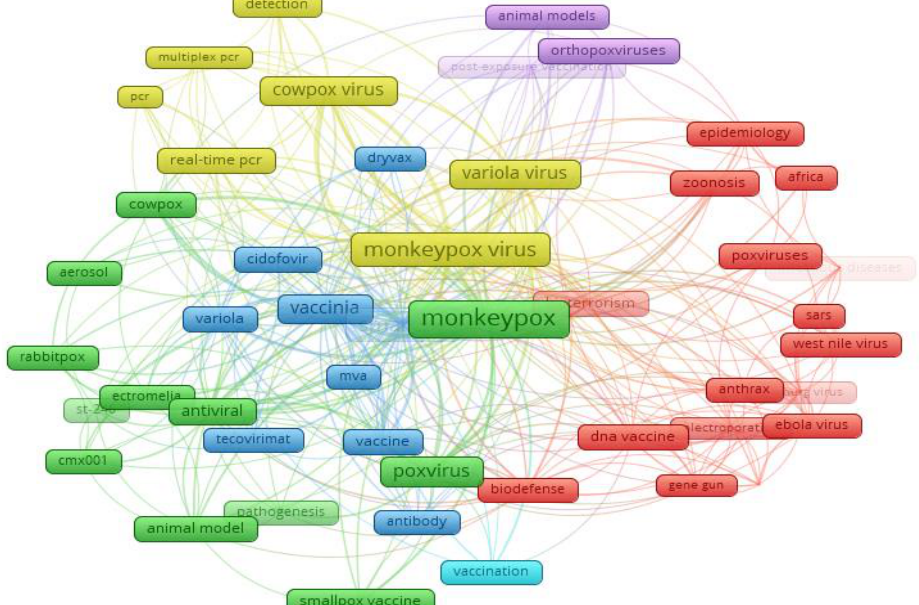
Figure 3. Top 50 author keywords found in MPV-related documents. Green, Red, Blue and Pink are the first four clusters; Red, the second; Yellow, the third; Blue, the fourth; and Pink, the fifth.